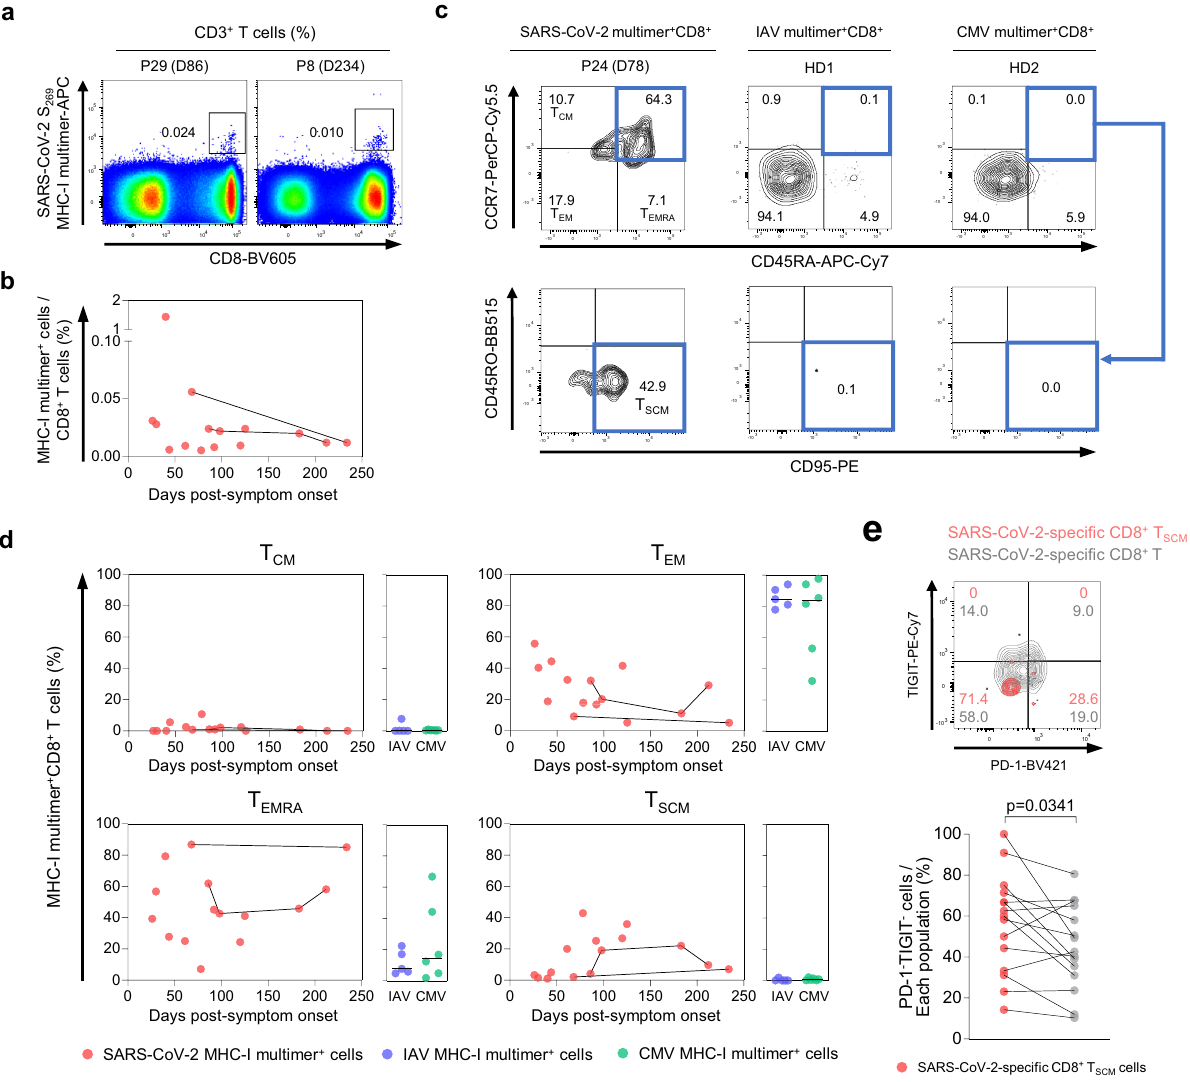
Fig. 4 Frequency and differentiation status of SARS-CoV-2-speci fi c MHC-I multimer + T cells. PBMC samples ( n = 15) from individuals with SARS-CoV- 2 infection ( n = 11) were analyzed by fl ow cytometry. a Representative fl ow cytometry plots showing the ex vivo detection of SARS-CoV-2 S 269 multimer + CD8 + T cells in the gate of CD3 + T cells. b Scatter plot showing the relationship between DPSO and the frequency of SARS-CoV-2 S among total CD8 + T cells. Samples from the same patient are connected by solid lines. The expression of CCR7, CD45RA, and CD95 was analyzed in SARS-CoV-2 S 269 multimer + CD8 + T cells. IAV MP 58 multimer + ( n = 5) and CMV pp65 495 multimer + ( n = 6) cells from the PBMCs of healthy donors were also analyzed. Representative fl ow cytometry plots ( c ) show the proportion of the indicated subsets among multimer + cells, and scatter plots ( d ) show the relationship between DPSO and the proportion of the indicated subsets among SARS-CoV-2 S 269 multimer + cells. Samples from the same patient are connected by solid lines. Summary data showing the proportion of the indicated subsets among IAV multimer + and CMV multimer + cells are also presented ( d ). Horizontal lines represent median. e A representative fl ow cytometry plot (upper) and summary data (lower) showing the percentage of PD-1 − TIGIT − cells among SARS-CoV-2 S 269 multimer + CD8 + T SCM cells and total SARS-CoV-2 S 269 multimer + CD8 + T cells. Statistical analysis was performed using the two-sided Wilcoxon signed-rank test ( e